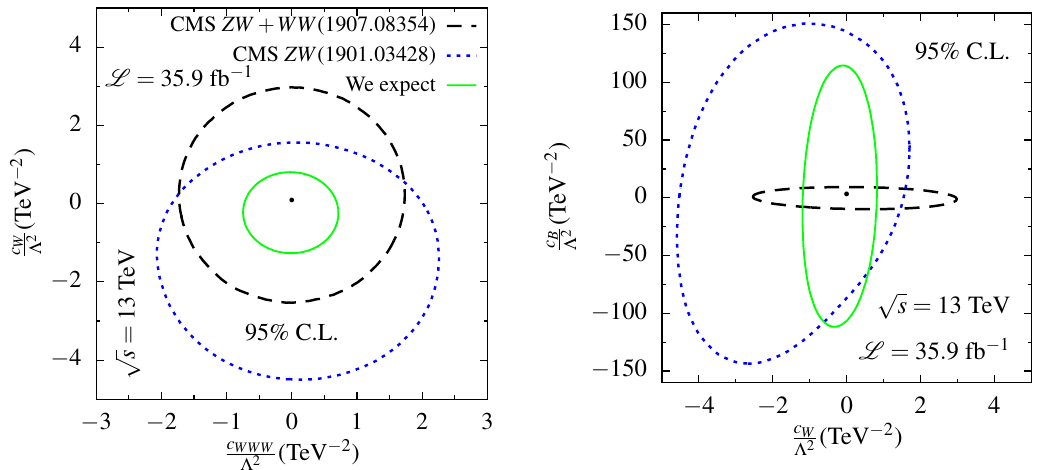
2 { c 2 plane ( left-panel ) WWW = (cid:3) W = (cid:3)